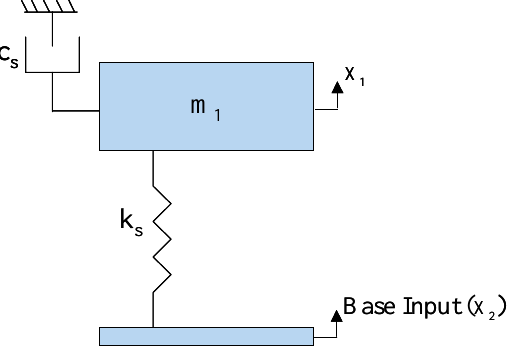
Fig. 1. Single Degree of Freedom (SDOF) base excited system.